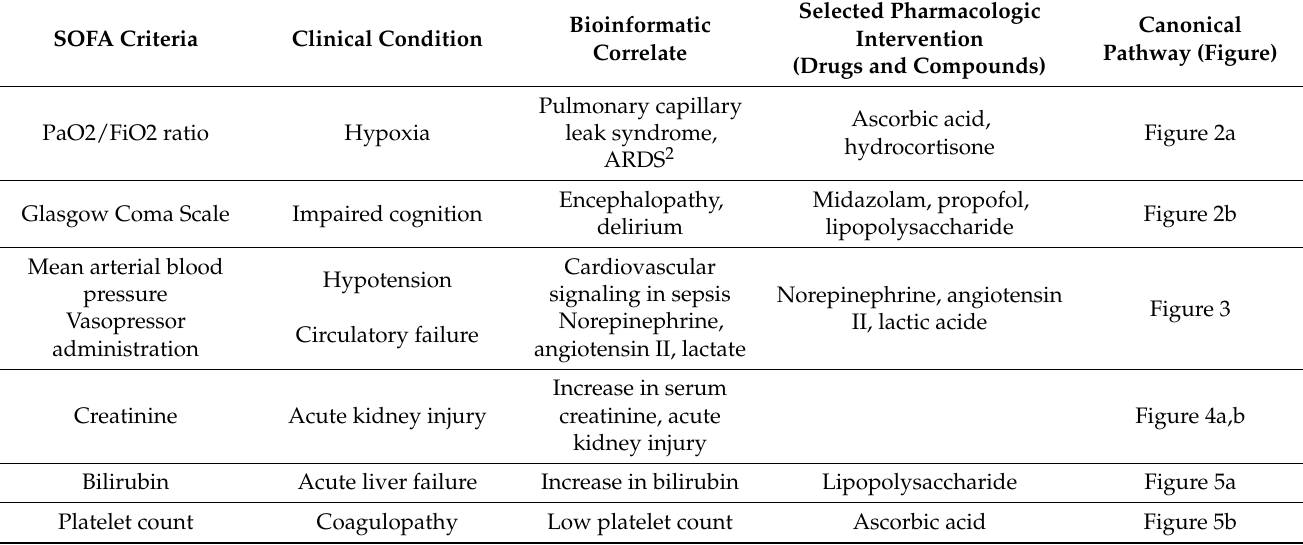
Table 1. SOFA criteria, their selected clinical correlates, and the bioinformatic filtering to disease states used for the con- struction of molecular networks from RNAseq data and for identification of target molecules of pharmacologic